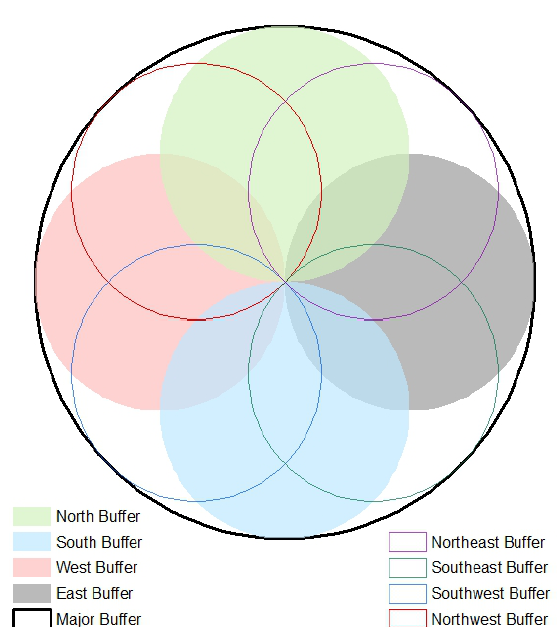
Figure 1. Relative spatial position of the multi-circular buffers considered in each single